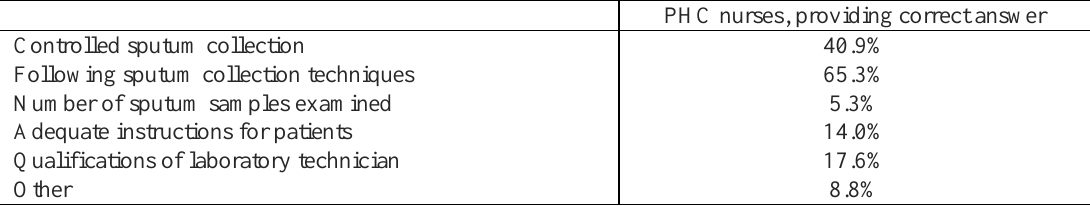
Table 3.Knowledge of factors influencing the reliability of sputum smear microscopy